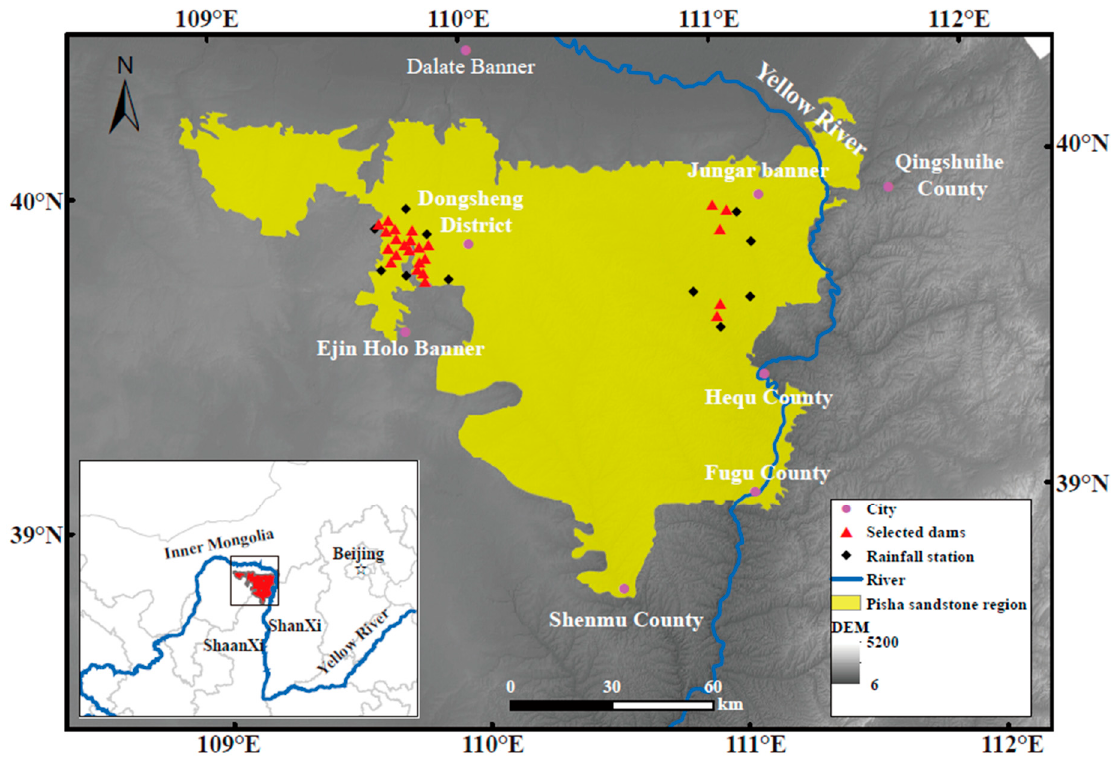
Figure 1. Locations of the check dams in the Pisha sandstone region of the Loess Plateau.